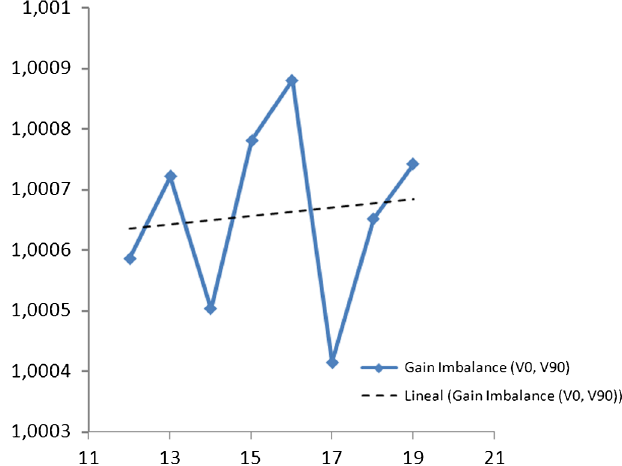
FIG. 3. Measured gain imbalance with several input levels; the horizontal axis is the input voltage in mV RMS and the vertical one is the measured gain imbalance of the Q channel with respect to the I